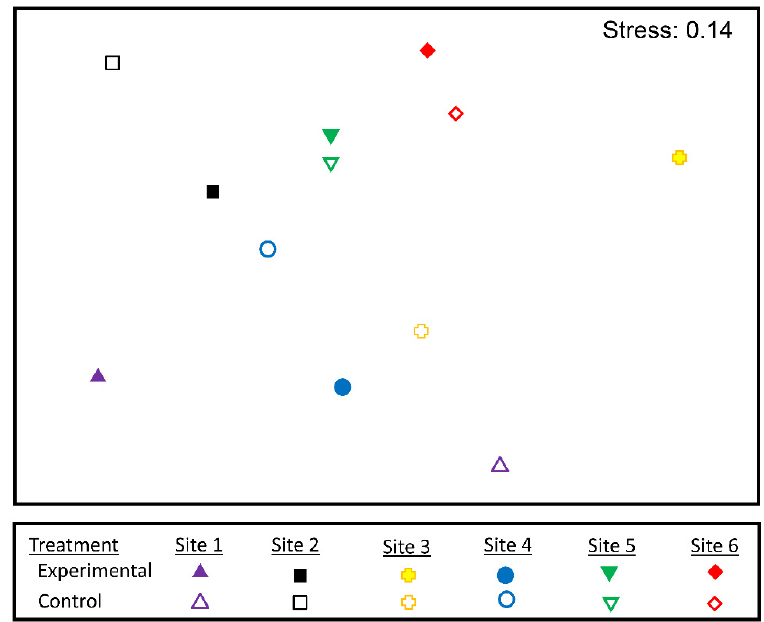
Figure 4. Number of Artemisia californica plants in each plot in 2019 and 2022 ( A ), and A. californica survivorship in each plot (( B ) Survivorship = number of plants in 2022/number of plants in 2019). We did not observe differences in soil biotic or abiotic characteristics between herbivore treatments that allowed and excluded herbivores. For example, bacterial (F 1 = 0.46, p = 0.52) and fungal (F 1 = 0.44, p = 0.63) abundances did not differ between control and experimental plots. Similarly, soil fungal assemblages did not differ (F 1 = 0.84, p = 0.58; Figure 5) when herbivores were excluded or allowed access. In addition, soil C (F 1 = 1.14, p = 0.47) and N (F 1 = 0.44, p = 0.63) concentrations did not differ between herbivore treatments. We reviewed the bacterial and fungal abundance data and C and N concentration data and confirmed that there were no differences that could be explained by partitioning data to compare sites in spot fires to those in the primary fire scar. Differences among sites were observed for fungal assemblage (F 5 = 1.42, p = 0.035) carbon concentrations (F 5 = 8.58, p = 0.004) and nitrogen concentrations (F 5 = 7.26, p = 0.002), though sites did not differ in microbial abundances (bacterial abundance F 5 = 1.14, p = 0.427; fungal abundance F 5 = 4.02, p = 0.051).